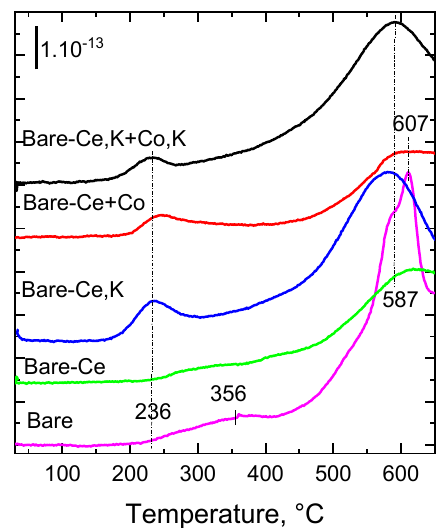
Figure 6. O 2 -TPD patterns of the examined catalysts.